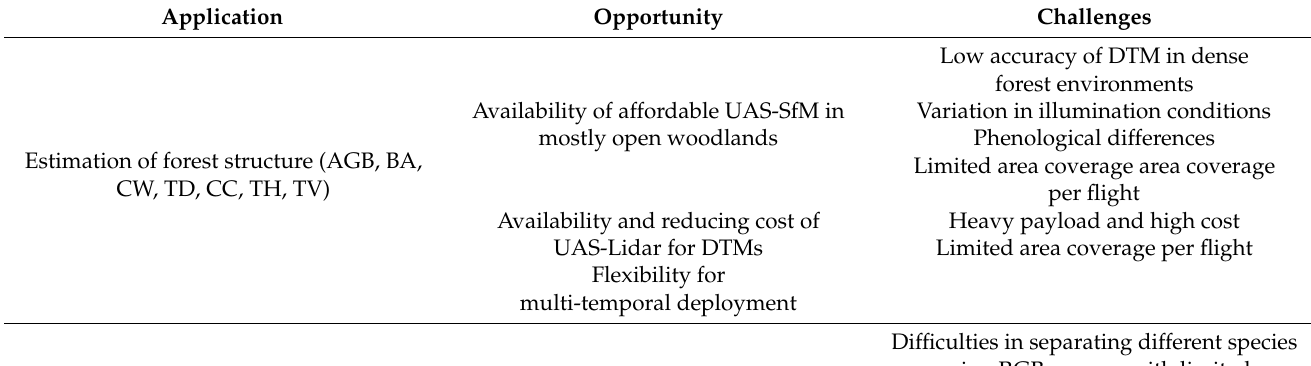
Table 6. Summary of opportunities and challenges for potential UAS application areas in the Miombo